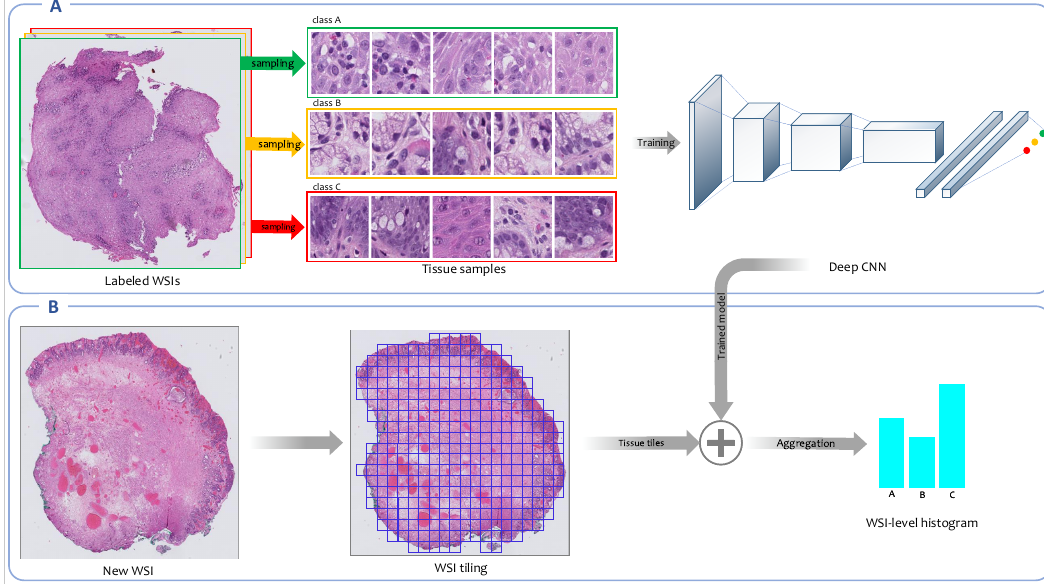
Figure 4. Overview of weakly supervised feature extraction framework. ( A ) A CNN is trained on high-resolution tissue tiles sampled from the labeled WSIs in the training set. This model uses only the reported diagnoses as labels for training WSIs and assumes that sampled tissue tiles have the same labels as their corresponding WSIs. ( B ) Once the training concludes, the trained model is employed to output the class’ probability distributions for each high-resolution tissue tile generated from new WSIs. The patch-level probabilities corresponding to all patches derived from a WSI are aggregated into a WSI-level probabilities